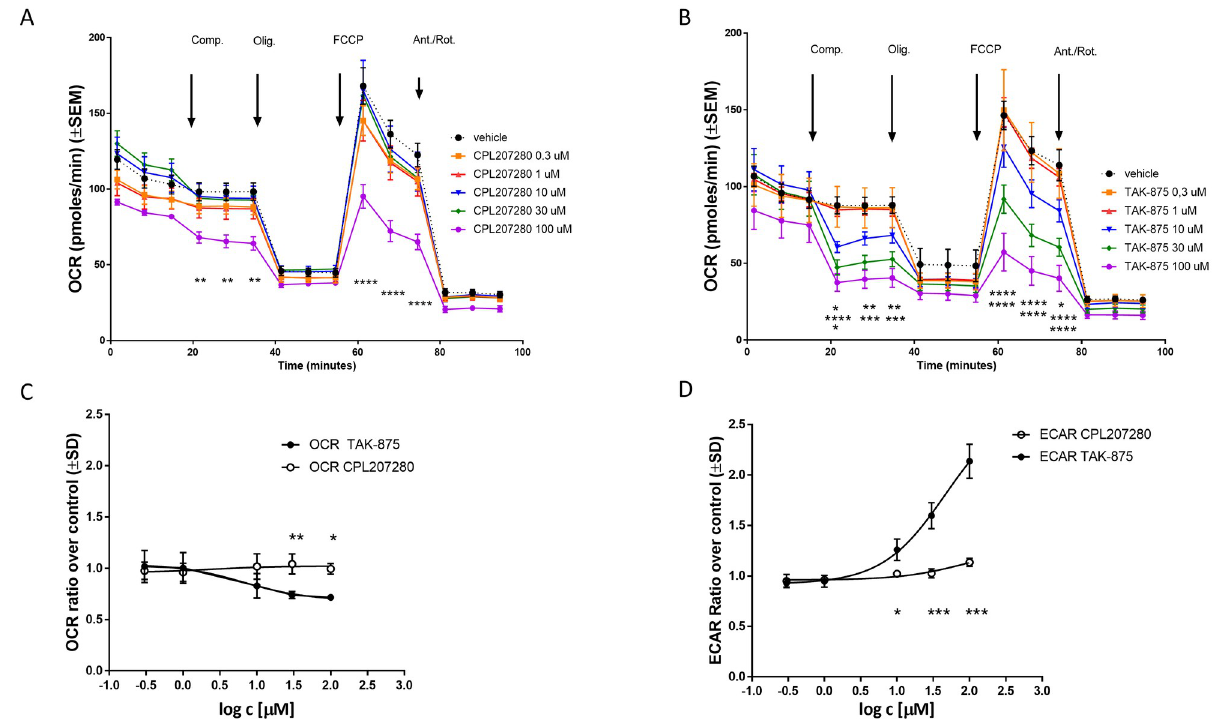
Fig 2. The effect of CPL207280 and TAK-875 on hepatocyte respiration. Representative tracing of oxygen consumption rates following a mitochondrial stress test in HepG2 cells treated with CPL207280 (A) and TAK-875 (B). Basal Oxygen Consumption rate (C) and Extracellular Acidification Rate (D). Statistical analysis was made by Two-Way ANOVA followed by Sidak’s post-hoc test. ��� , p < 0.001; �� , p < 0.01; � , p < 0.05; n = 3.